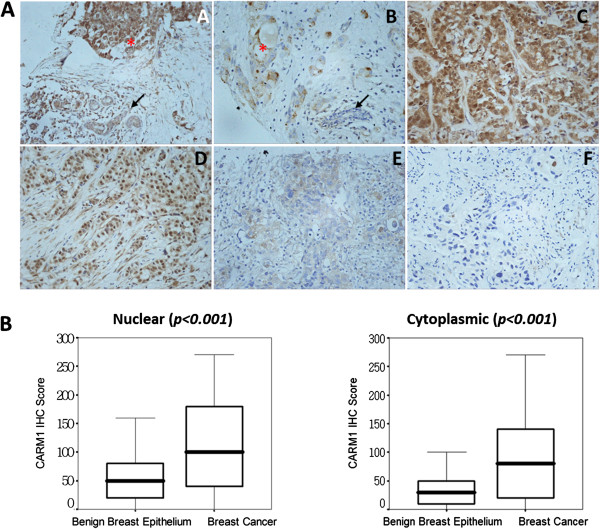
The expression pattern of CARM1 in human invasive breast cancer (×400). A In positive samples, the expression of CARM1 in adenocarcinomas was considerably increased compared with the adjacent benign glandular epithelium (A and B). The increased expression was both nuclear and cytoplasmic (C), predominantly nuclear (D), or predominantly cytoplasmic (E). A representative negative case is shown (F). Asterisks indicate adenocarcinoma. Arrows indicate benign breast epithelium. B CARM1 expression was increased significantly in invasive breast cancer compared with benign epithelium (one-way ANOVA P < 0.001).